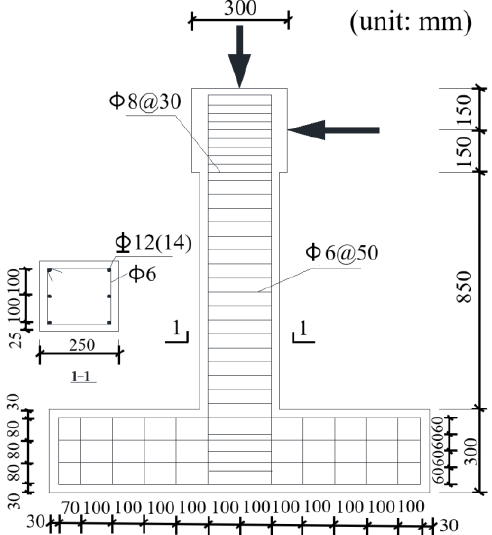
Figure 1. Diagrammatic sketch of reinforced-concrete (RC) columns.